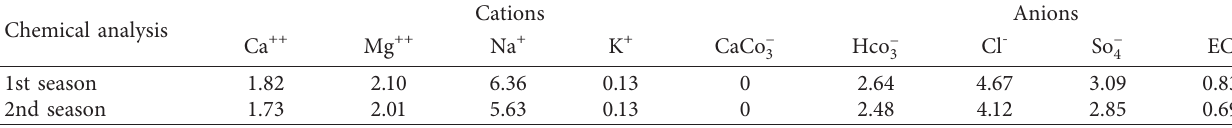
Table 2: Chemical analysis of the soil experimental field.